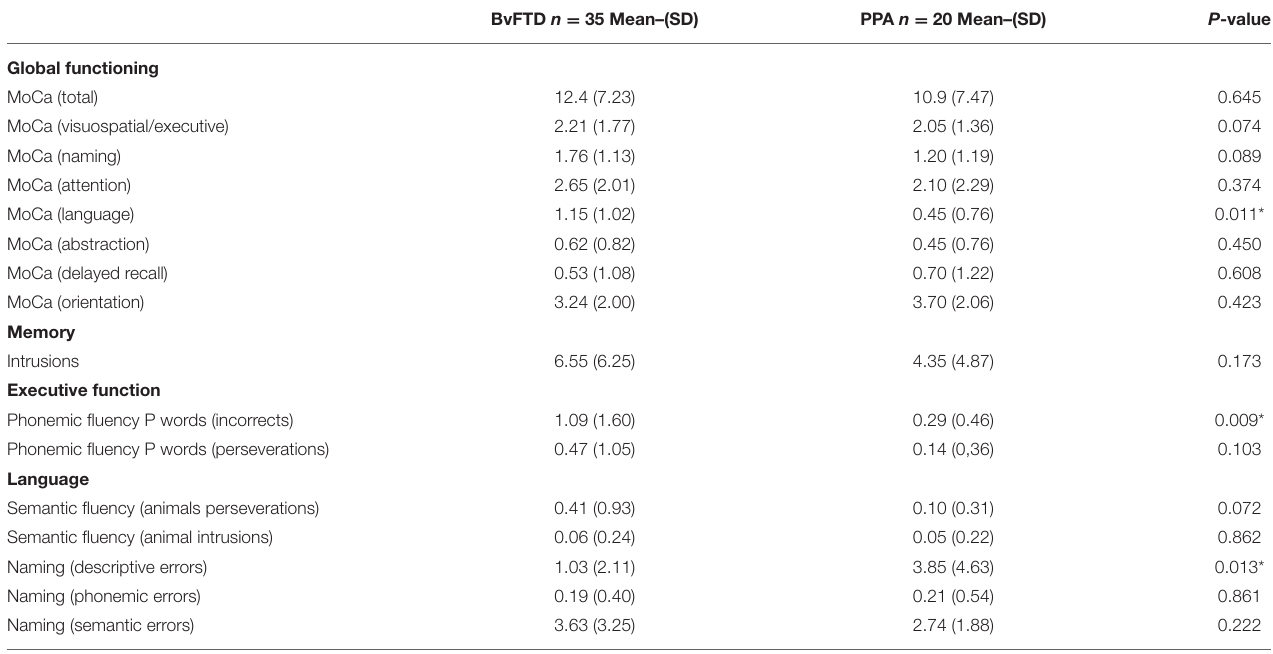
TABLE 3 | Profile of errors, false positives, perseverations, and MOCA subtest of bvFTD and PPA